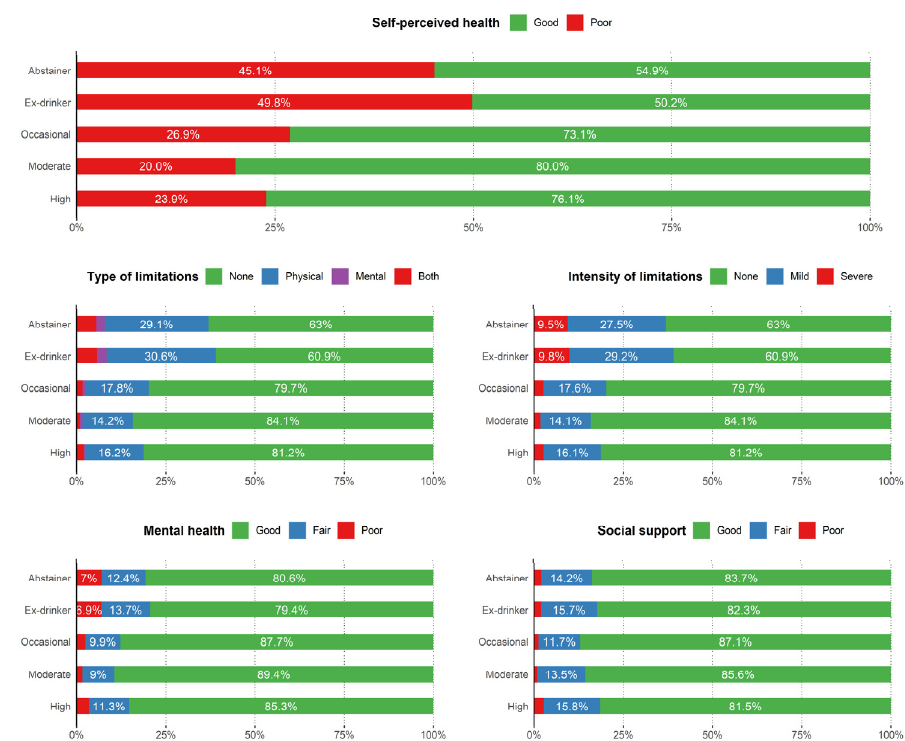
Figure 1. Percentages of self-perceived health, type, and intensity of daily functional limitations, mental health and social-affective support in the Spanish adult population ( ≥ 18 years) according to beer consumption. Alcoholic beer drinkers were finally classified as occasional (a maximum of 3 days per month), moderate (women: up to 12 g of alcohol per day; men: up to 24 g of alcohol per day) or high (women: more than 12 g of alcohol per day; men: more than 24 g of alcohol per day). National Health Survey of Spain 2012, 2017.